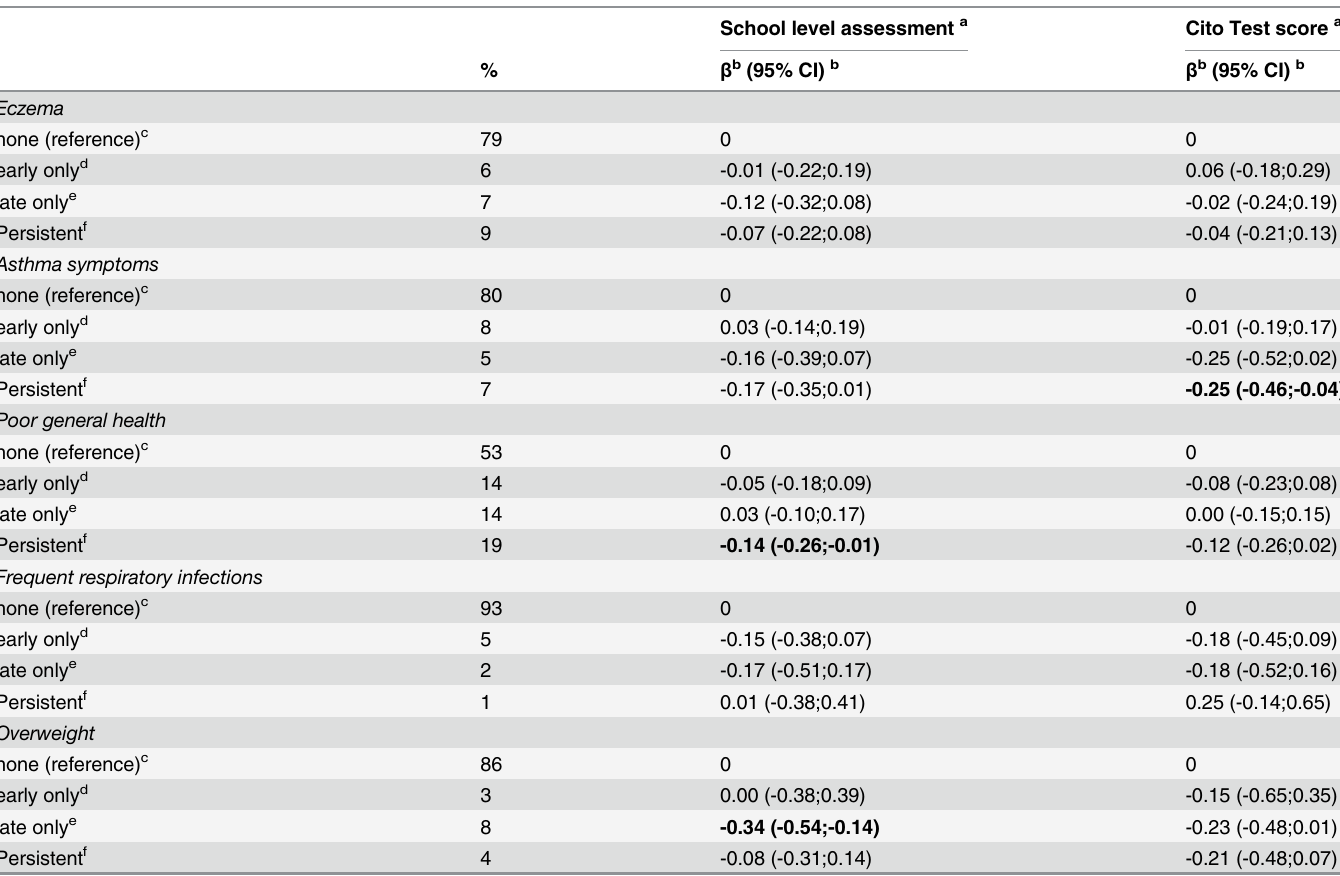
Table 5. Association between children ’ s health trajectories and school level assessment (n = 1,865) and Cito Test score (n = 1,531)